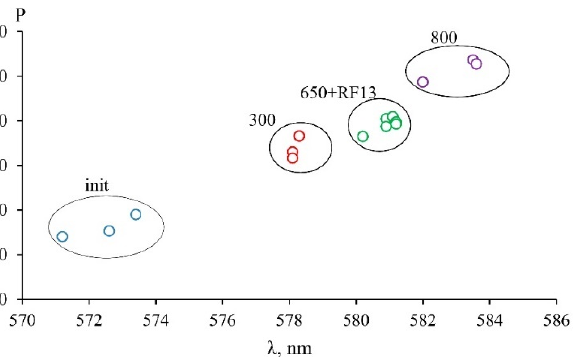
Figure 5. The ratio between the color tone intensity (P) and dominant wavelength ( λ ) of the MF samples roasted at different temperatures and the RF13 sample roasted at 700 °C.